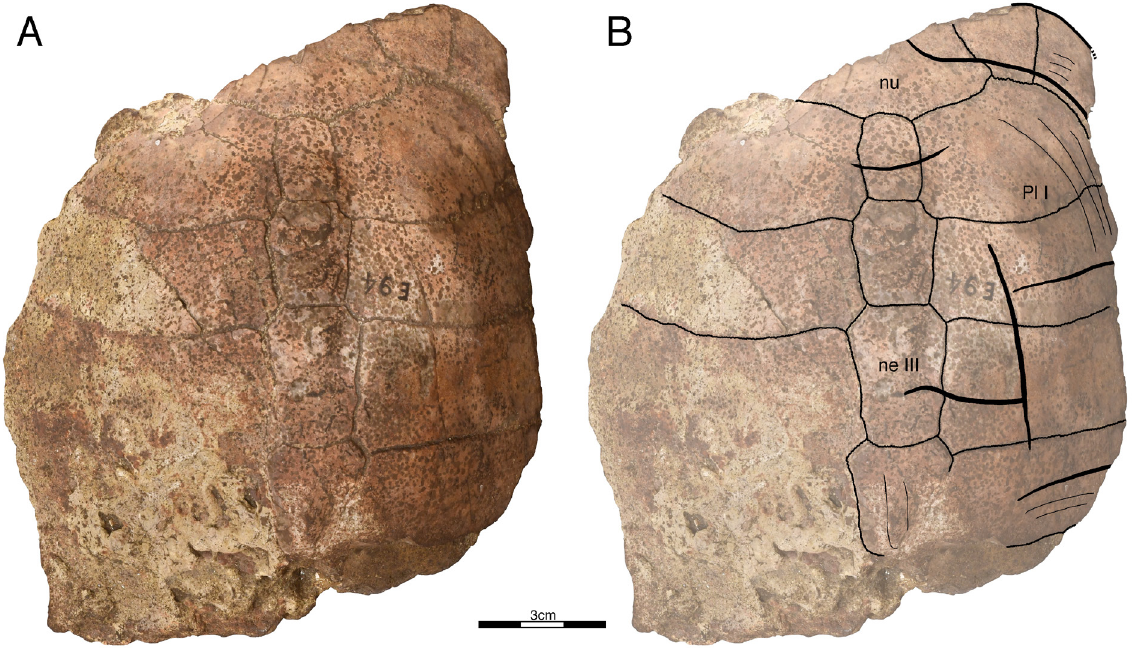
Fig. 9. IM E.94, referred to Batagur falconeri Lydekker, 1885, here identified as Palatochelydia indet. A . Photograph of carapace. B . Illustration of carapace. Scale bar: